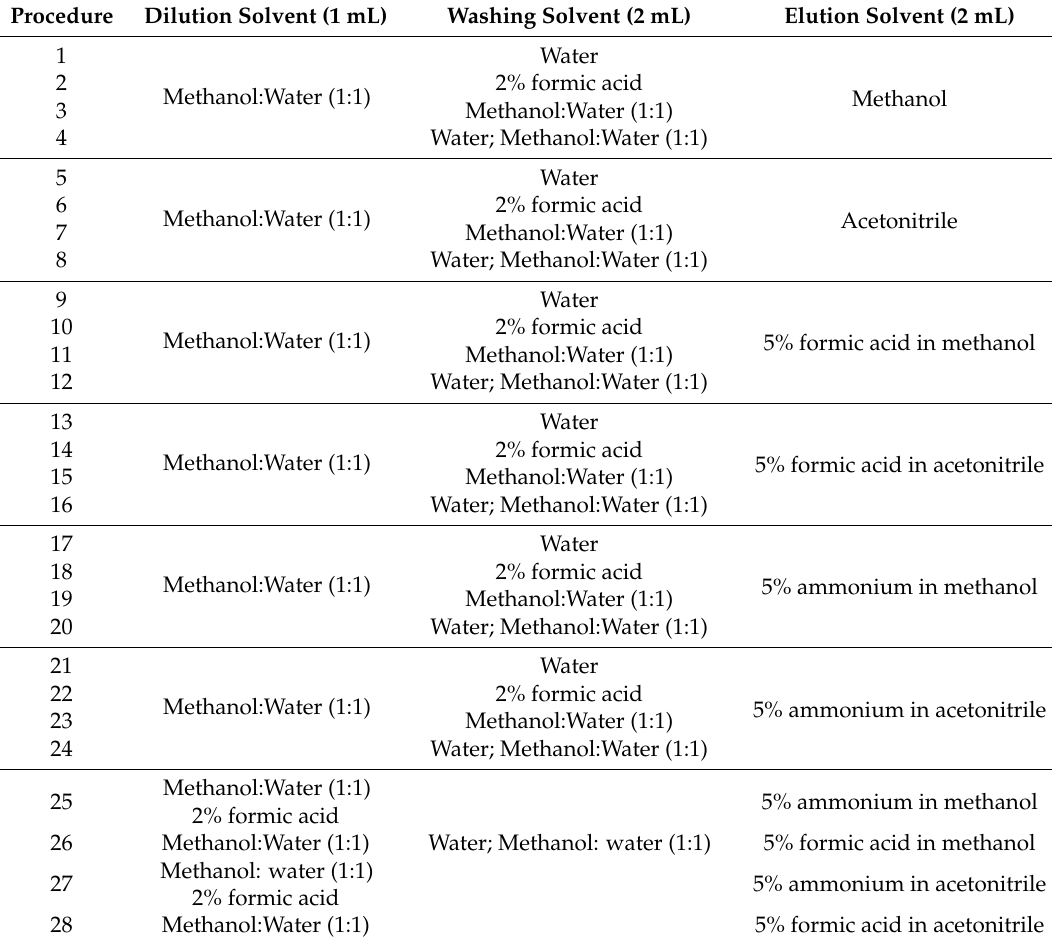
Table 1. Procedures used to examine the efficacy of solid phase extraction of